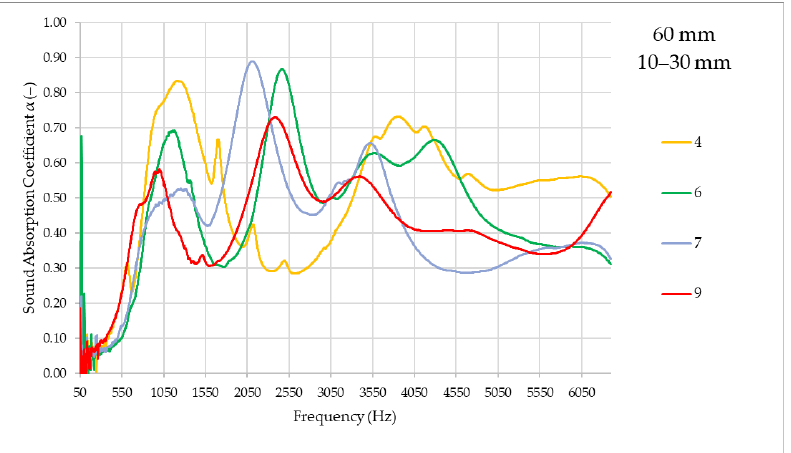
Figure 5. Sound absorption coefficient as a function of frequency of tested specimens of bark panels 4, 6, 7 and 9 with a thickness of 30 mm and a grain fraction of 10 to 30